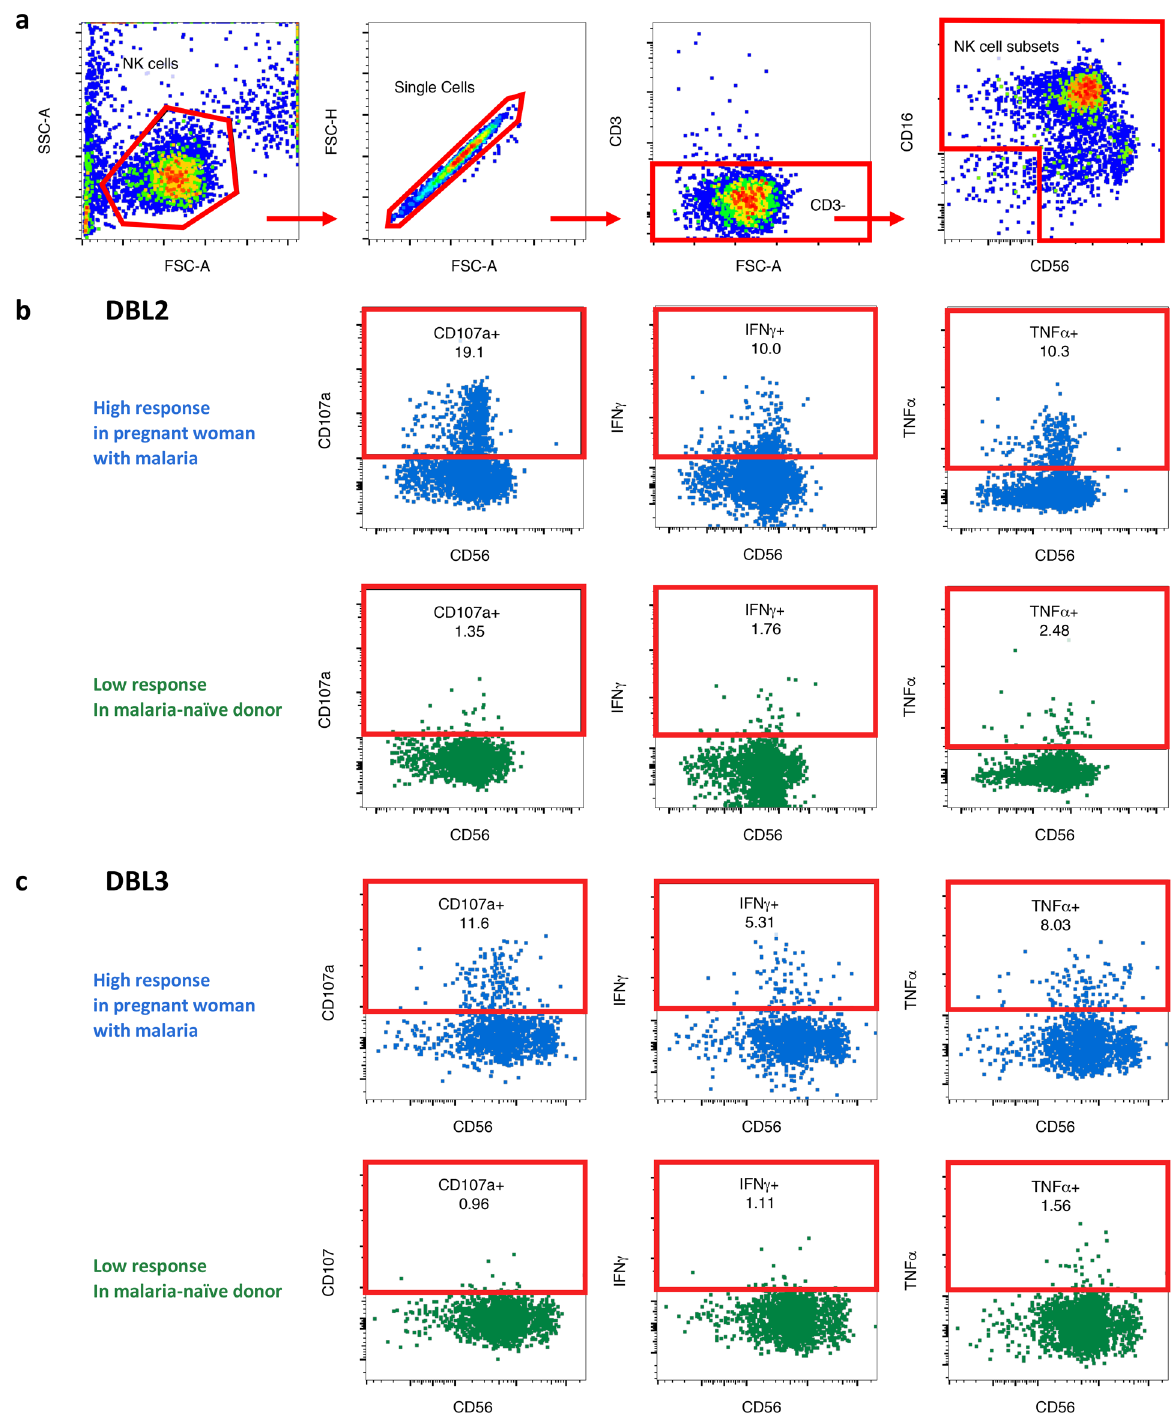
Figure 2. Gating strategy to identify NK cell activation markers. Purified NK cells were incubated with IgG test samples in presence of DBL2 or DBL3 for 5 h and then analyzed via flow cytometry. Representative flow cytometry plots of one sample to visualize gating strategy. ( a ) NK cells were identified by sequentially gating on lymphocytes, single cells, CD3 - cells, and NK cell subsets. NK cells subsets were gated as one and assessed for surface CD107a expression and intracellular IFNγ and TNFα production in presence of DBL2 ( b ) and DBL3 ( c ) (High response = blue; malaria-naïve response =